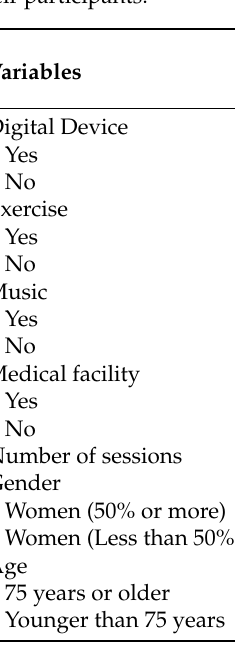
Table 1. Descriptive statistics about the characteristics of the examined intervention programs and their